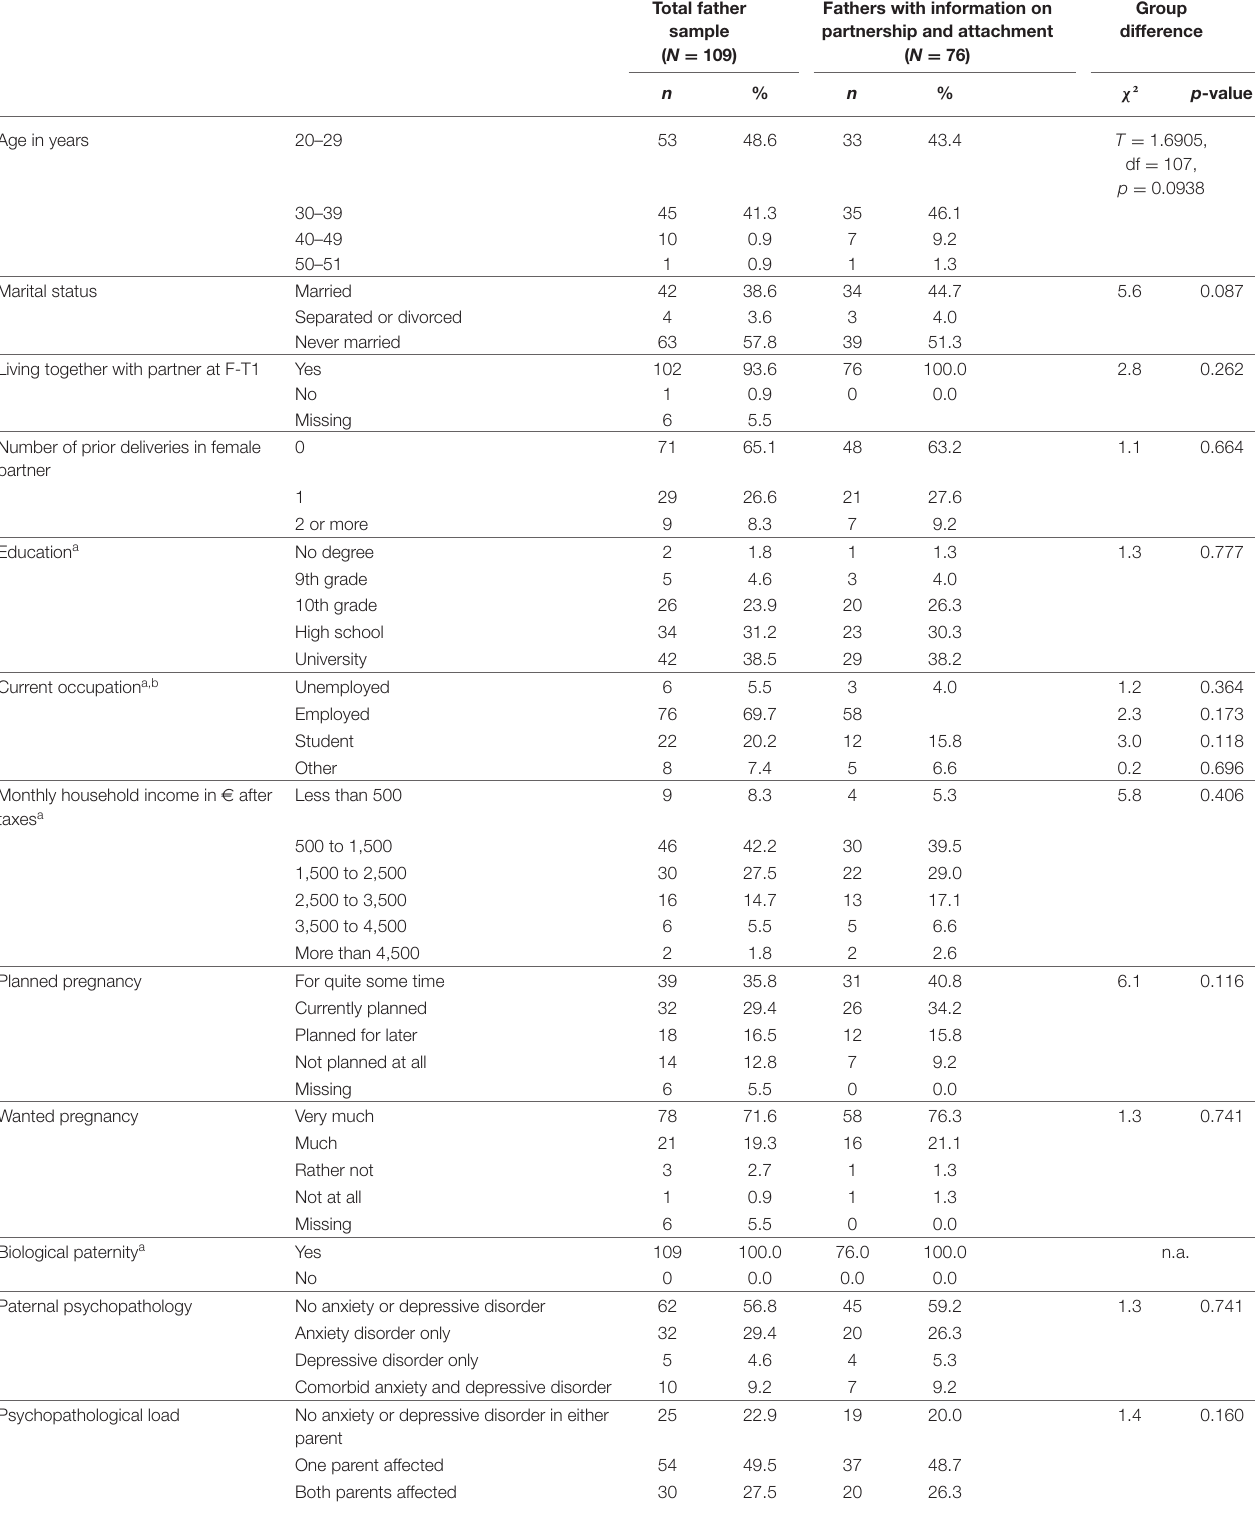
TABLE 1 | Sample characteristics of the MARI-father study at